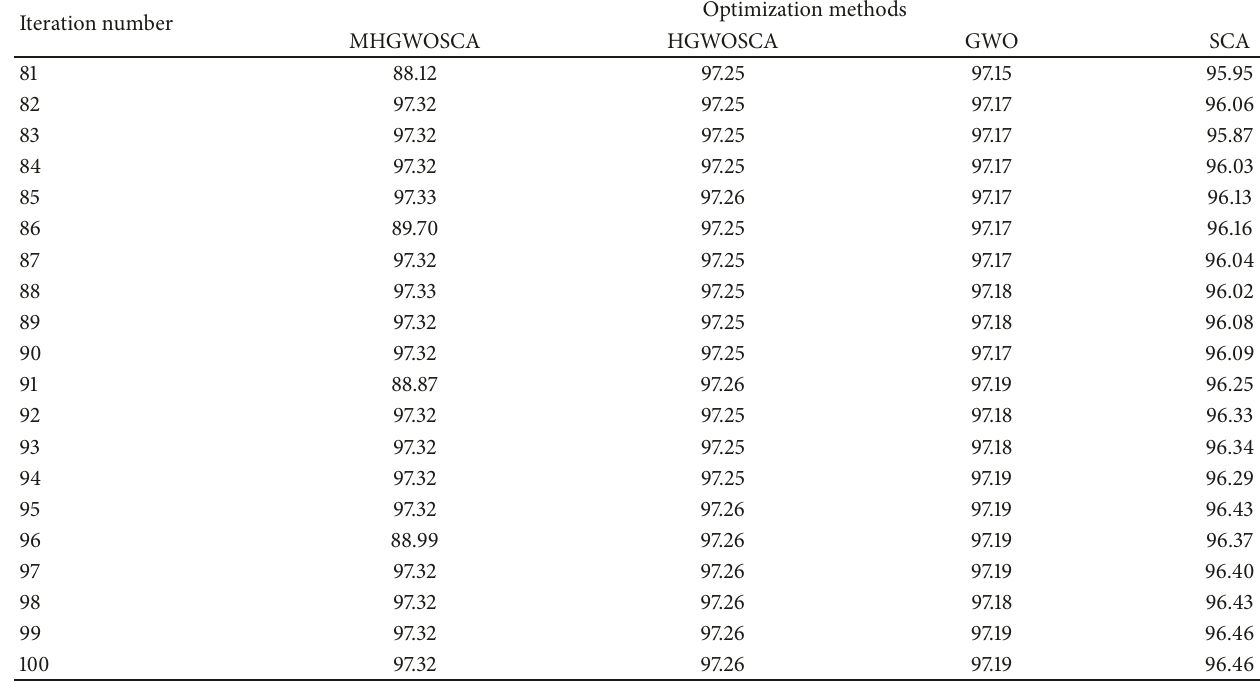
Table 5: The average fitness value of individuals during